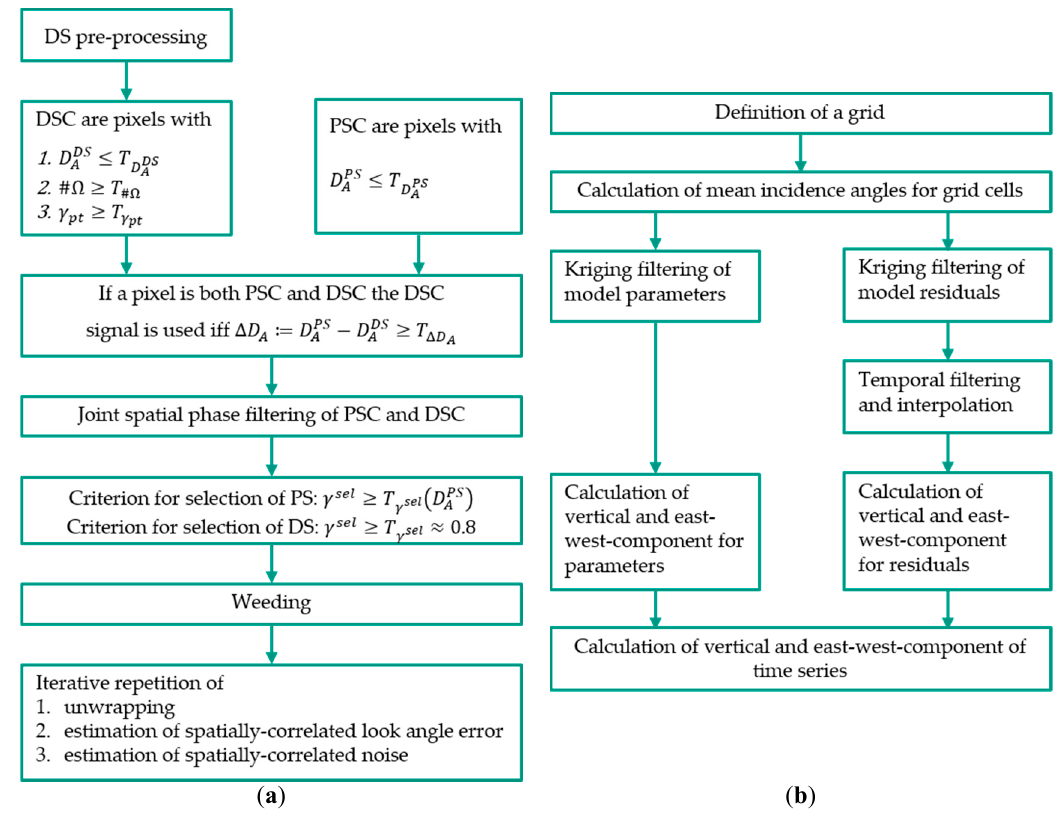
Figure 4. Flowcharts for joint processing of PS and DS and for orbit combination. Symbols are explained in the text.